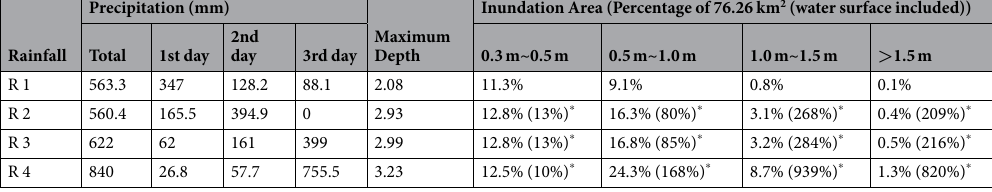
Table 1. Rainfall type and inundation area in different depths. * Percentage numbers inside the bracket are meaning the increased percentage compared with the inundation area of